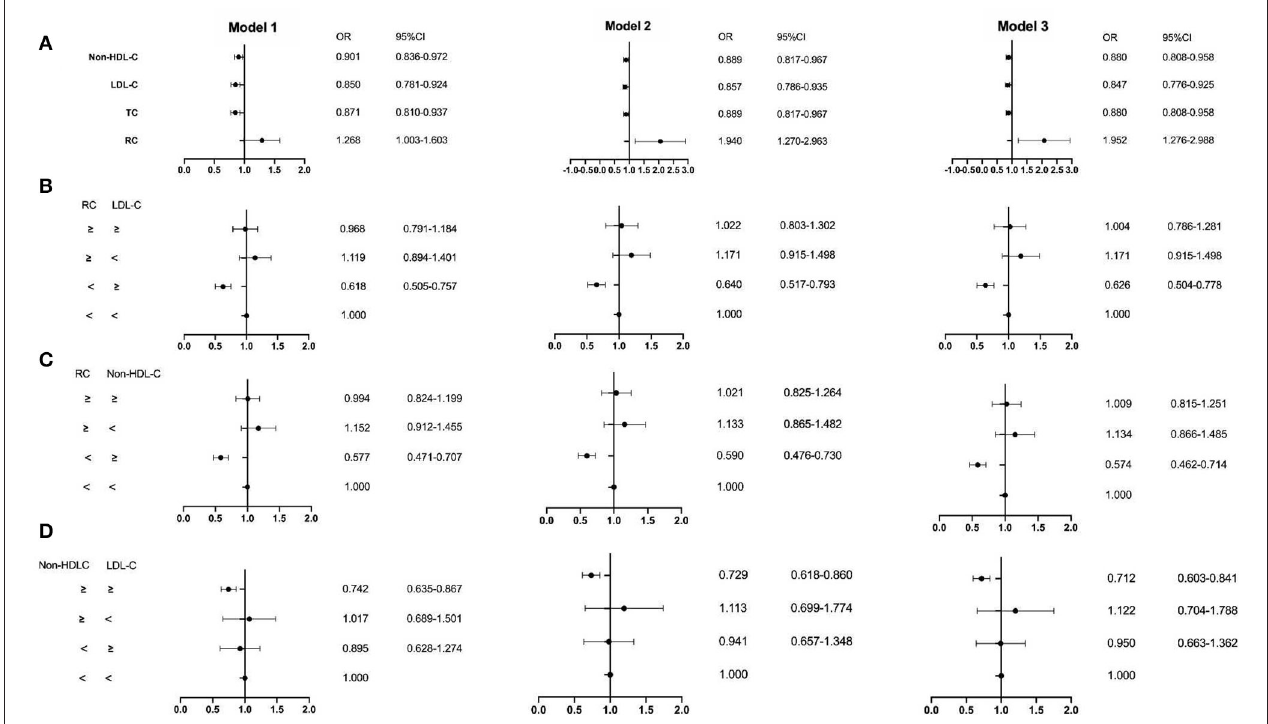
FIGURE 3 | The result of the multivariable logistic regression analyses after PSM. (A) Non-HDL-C, LDL-C, TC, and RC; (B) the RC and LDL-C group; (C) the RC and non-HDL-C group; (D) the non-HDL-C and LDL-C group. Model 1: age, gender, hypertension, hypercholesterolemia, smoking, diabetes, and BMI; Model 2: Model 1, SBP, DBP, FBG, HbA1C, HDL-C, and TG; Model 3:Model 2, creatinine, uric acid, hs-CRP, BNP, WBC, and